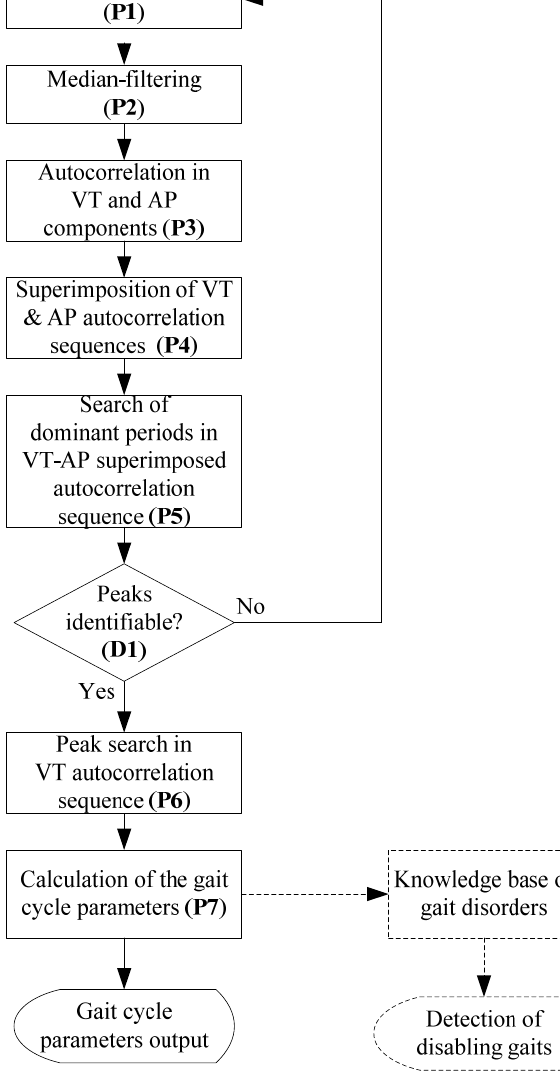
Figure 5. The process flowchart of real-time gait cycle parameters